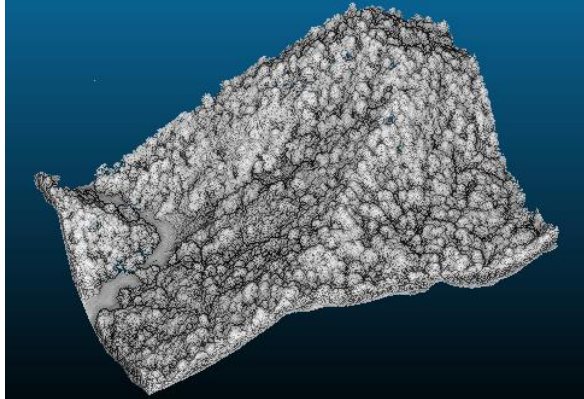
Figure 4. Overview of the classification data